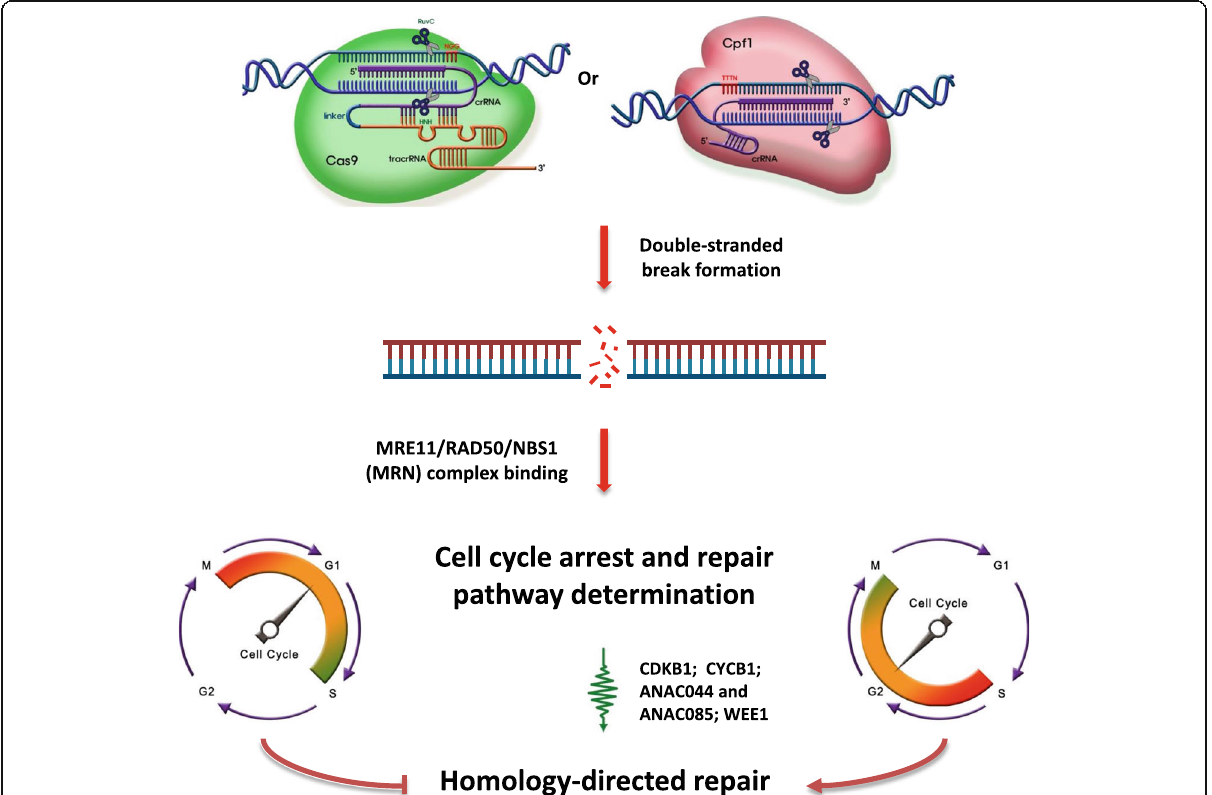
Fig 4 Homology-directed repair pathway determination and its favorable cell contexts. Activation of the MRN complex and P53/SOG1 triggers the activation of cell cycle checkpoint proteins such as CDKB1 (G2/M checkpoint) and CYCB1 (S phase checkpoint) or NAC-type transcription factors ANAC044 and ANAC085 (S/G2 checkpoints) or WEE1 kinase for cell cycle